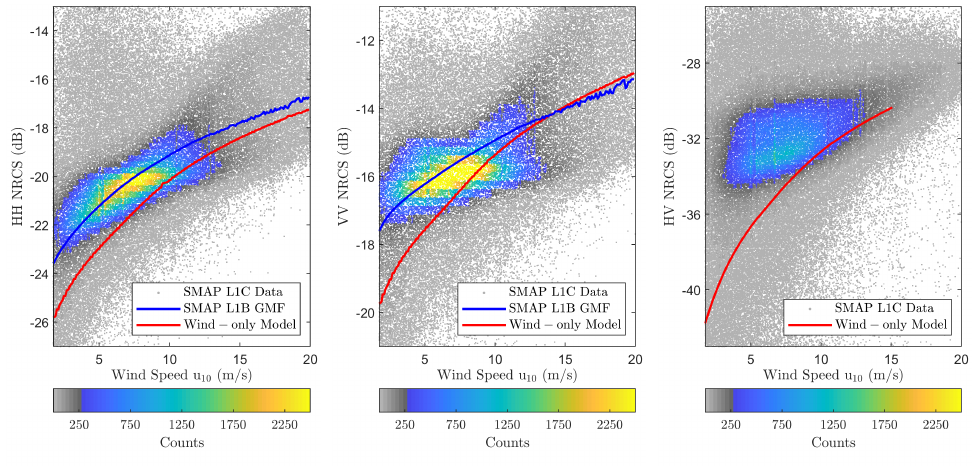
Figure 9. SMAP wind speeds vs. backscatter NRCS scatter density plots. Figures from ( left ) to ( right ) show HH-, VV-, and HV-polarizations. SMAP L1-B GMF (co-pol only) and wind-only model predictions (TSM for co-pol, SSA2 for cross-pol) are also